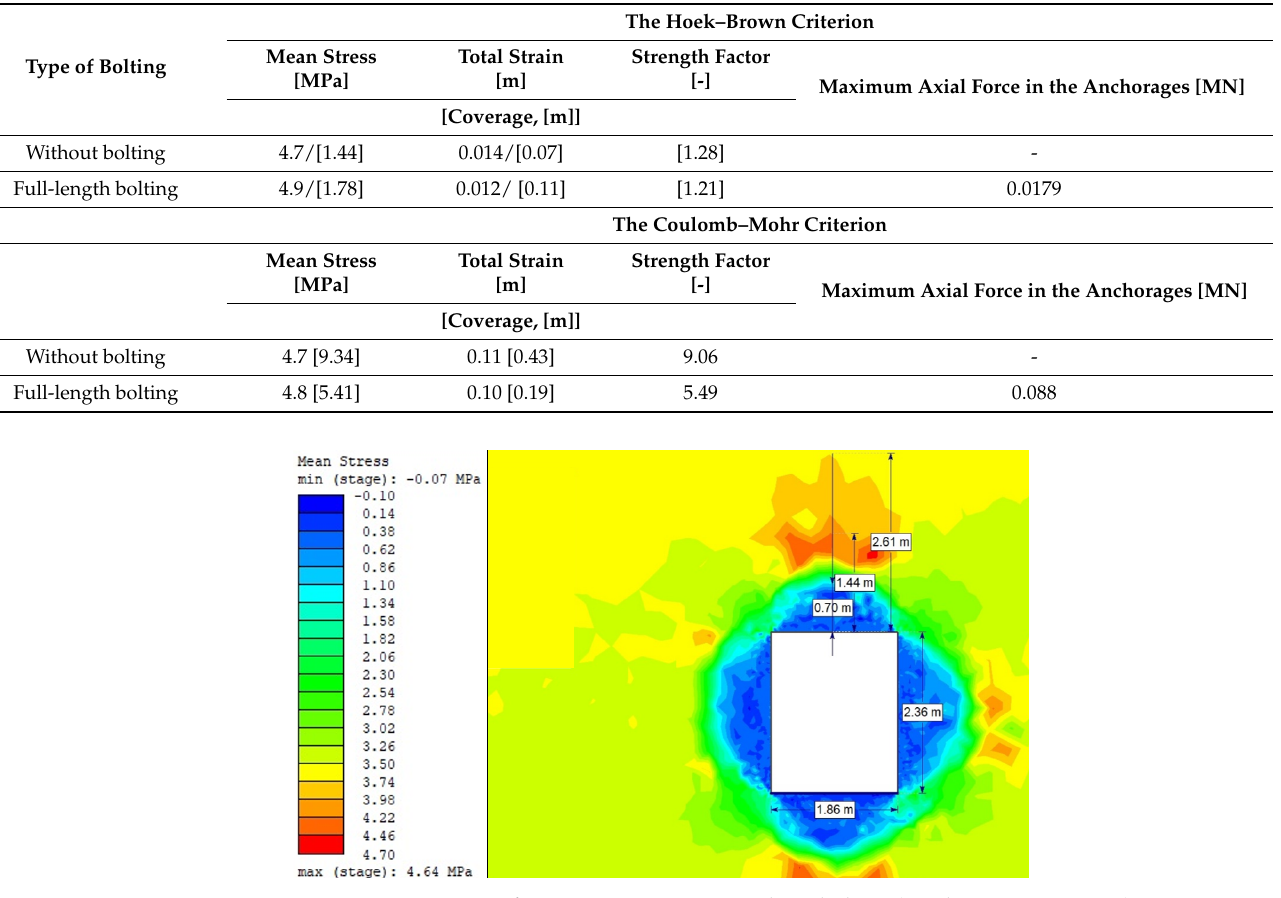
Figure 5. Mean stress for Vernier excavation without bolting (Hoek–Brown criterion).